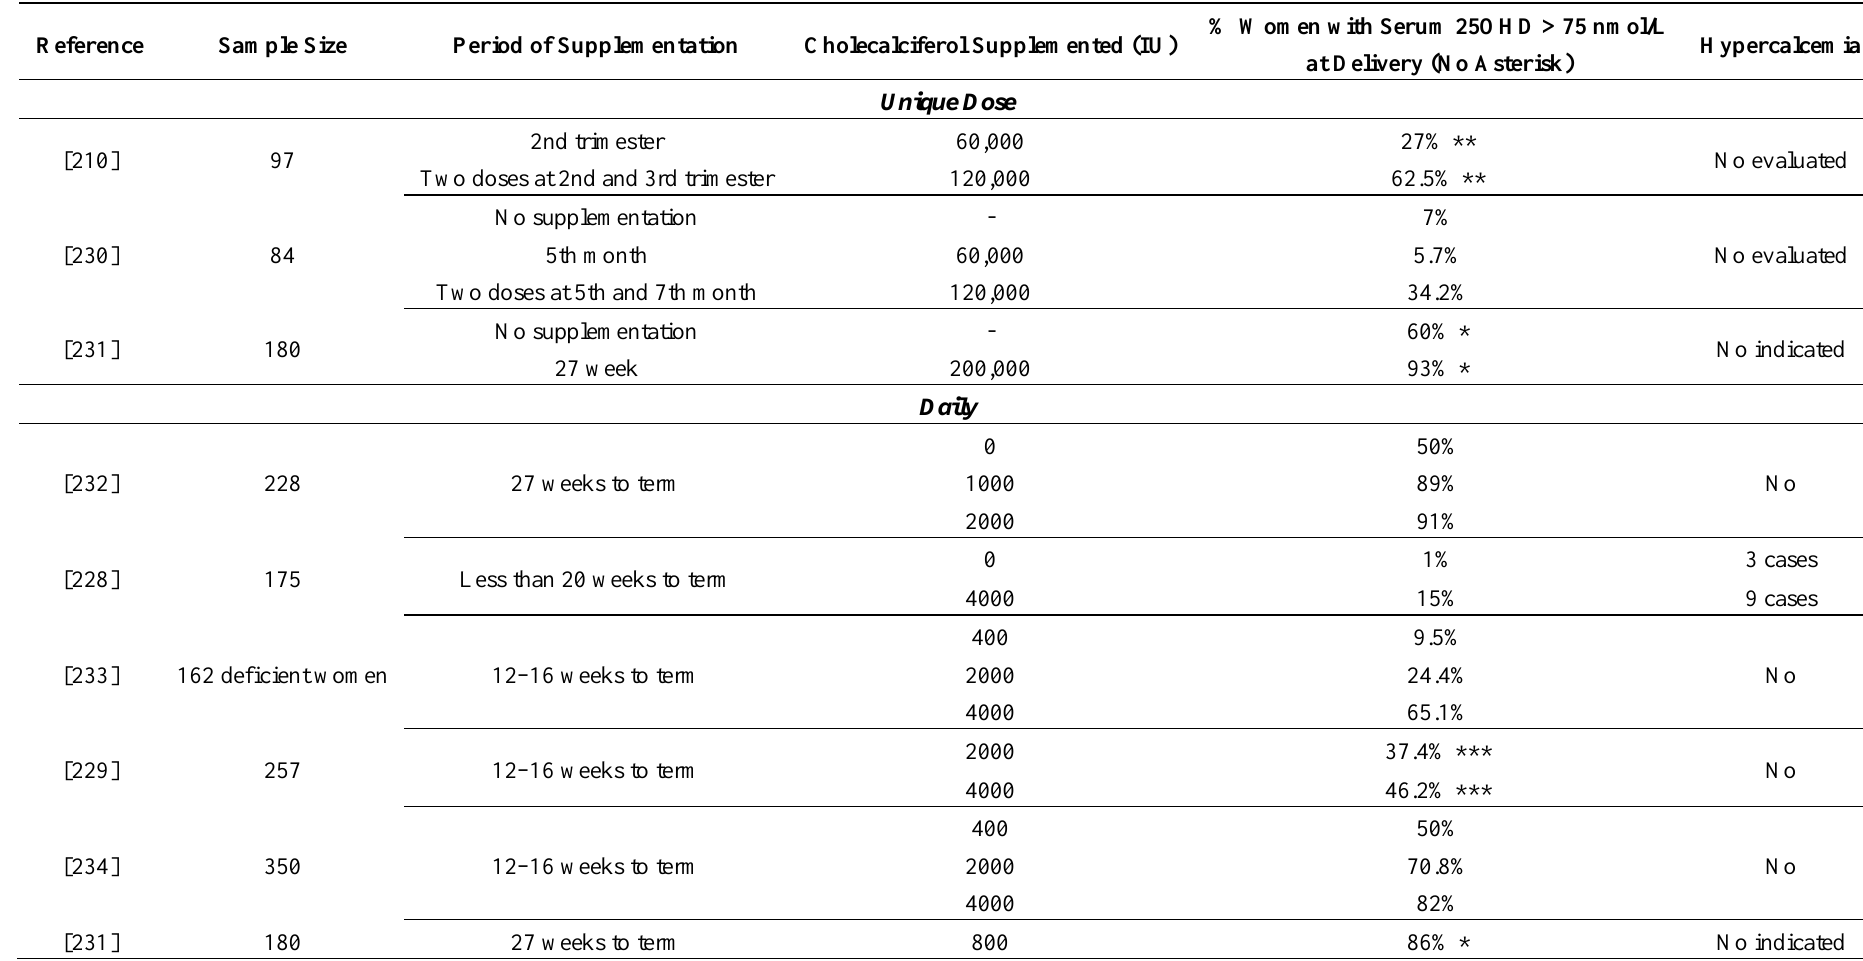
Table 5. Cholecalciferol supplementation and VD status in randomized clinical trials in healthy pregnant